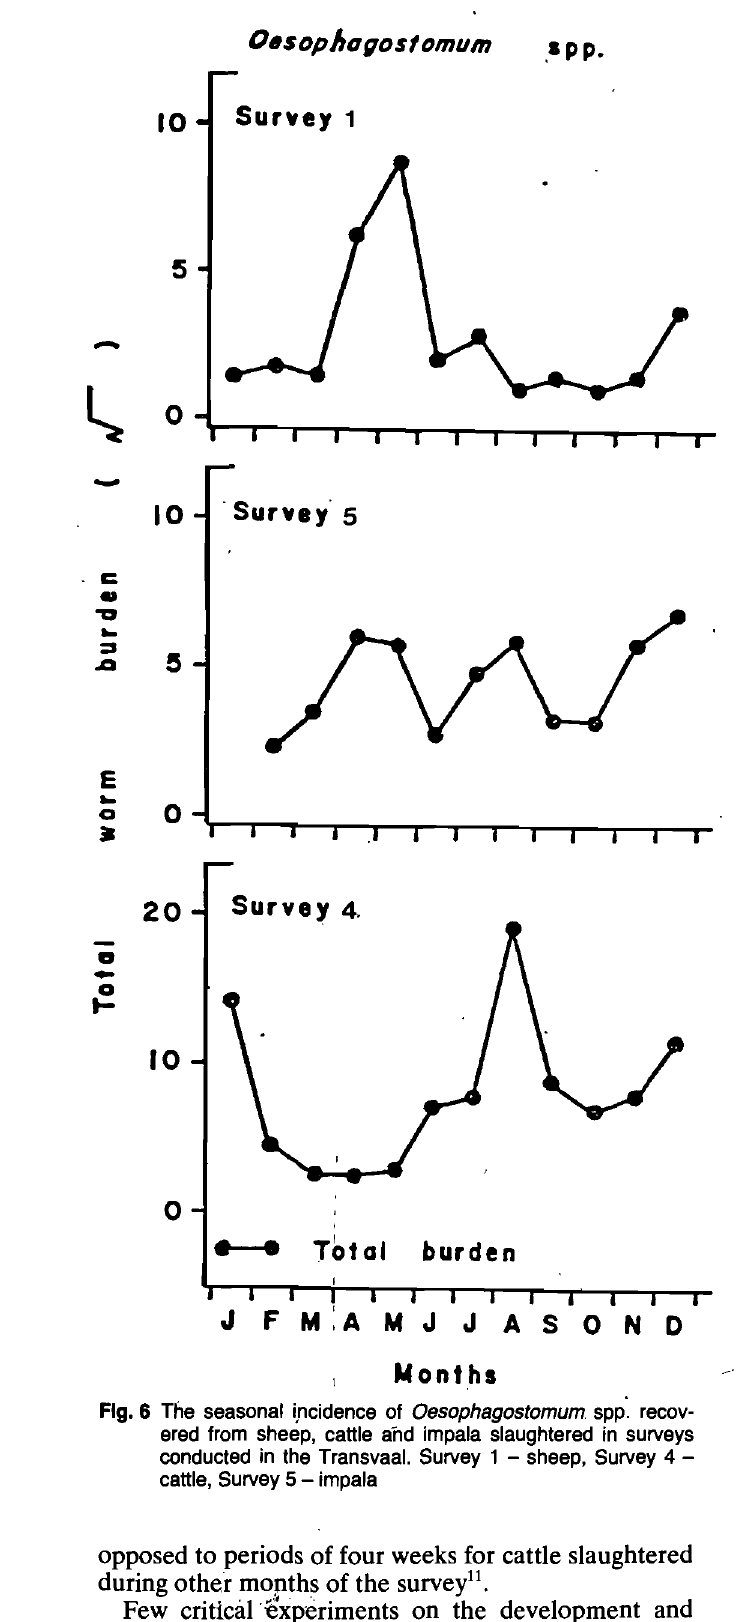
opposed to periods of four weeks for cattle slaughtered during other mo;nths of the